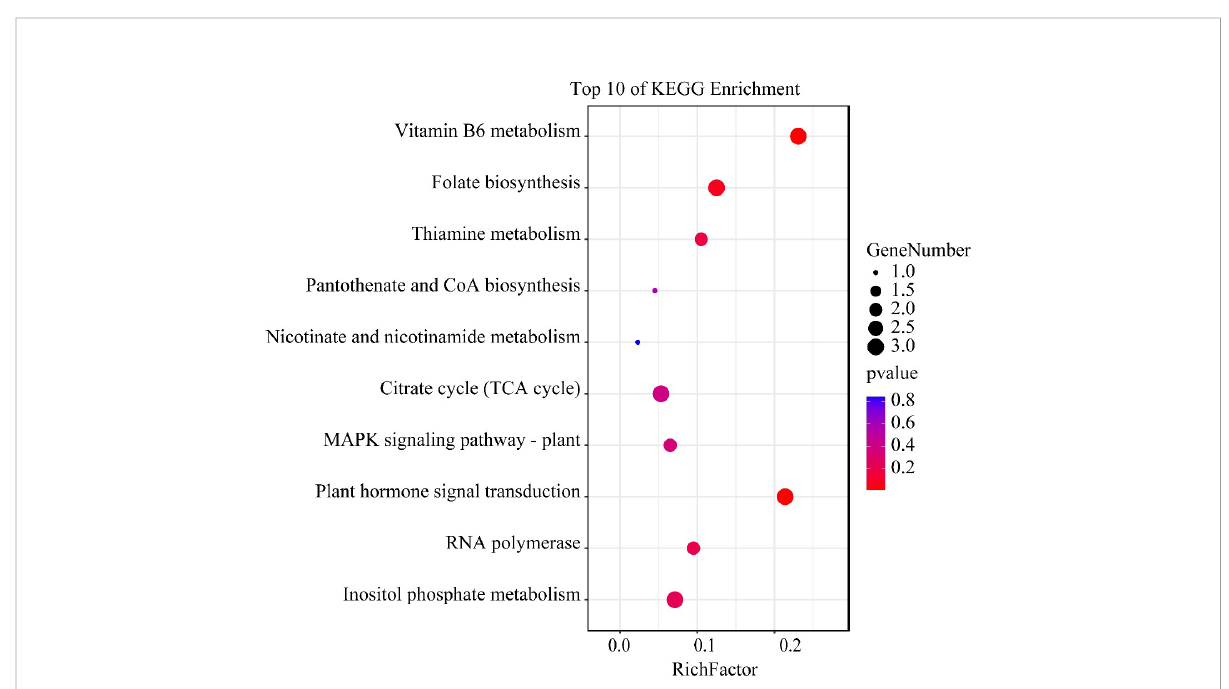
FIGURE 6 The top 10 enriched KEGG pathway terms of H3K4me3 associated genes unique to the HN condition in Alexandrium paci fi cum . RichFactor represents the ratio of the number of genes located in the KEGG term to the total number of genes located in the KEGG term in all annotated genes. The size of the circle represents the number of genes enriched in the term. The gradient of color from blue to red represents the size of the p value